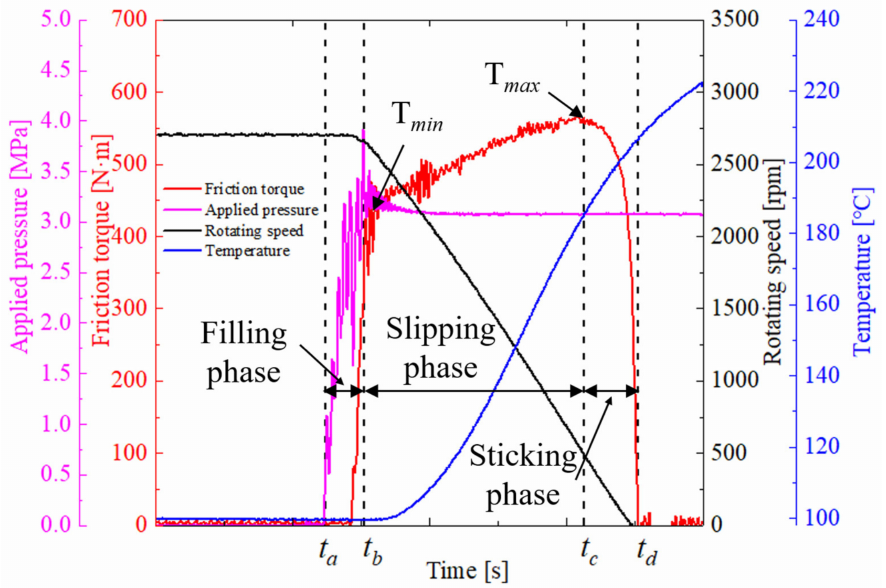
Figure 5. Representative measurement